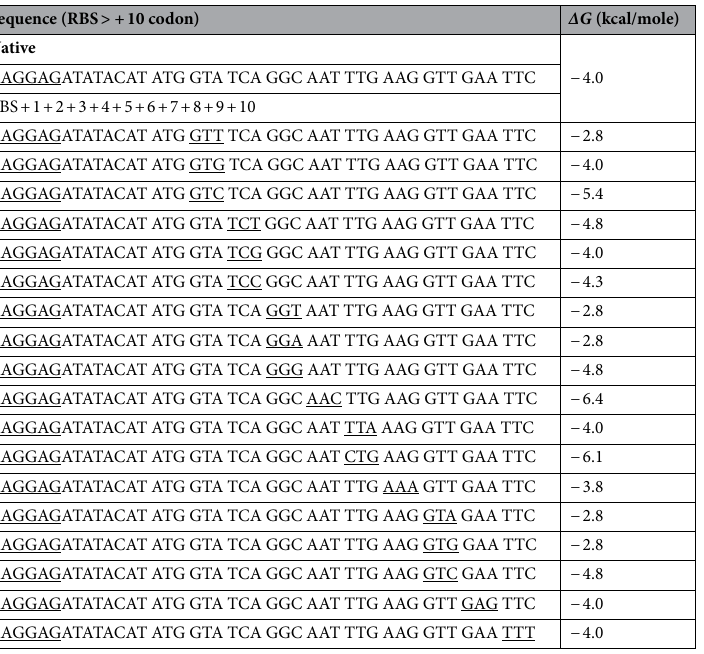
Table 1. Sequences and their respective ΔG values (RBS: ribosome binding site of pET22b